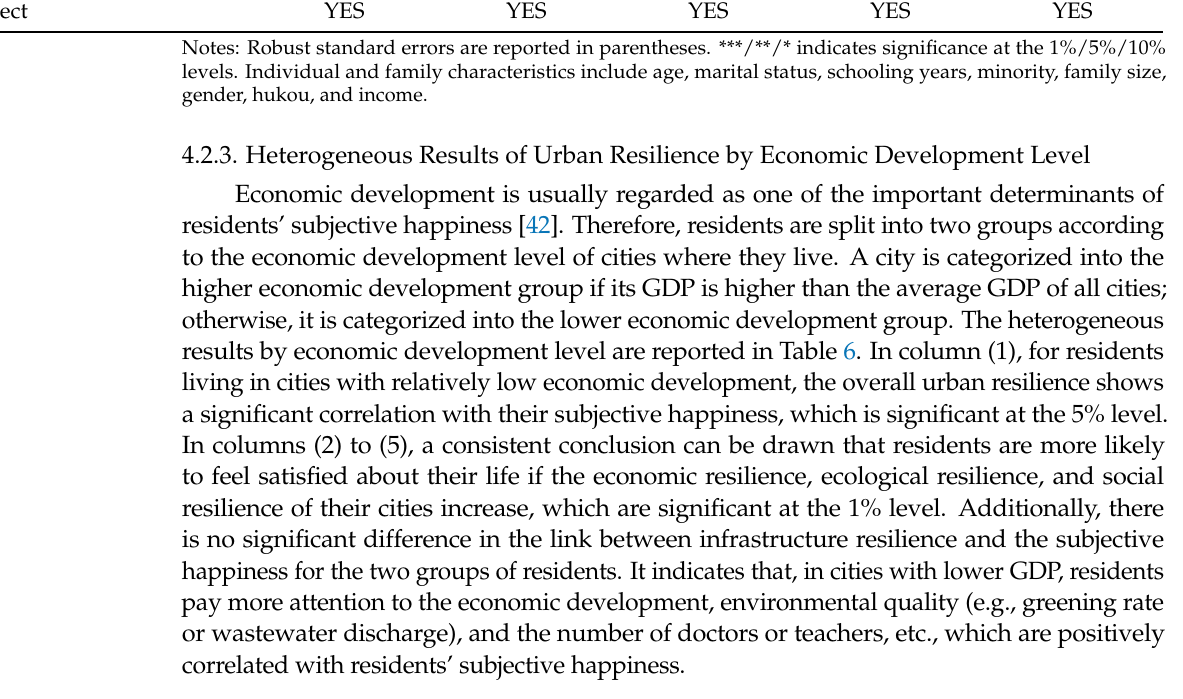
Table 6. Effect of urban resilience on residents’ subjective happiness by economic development